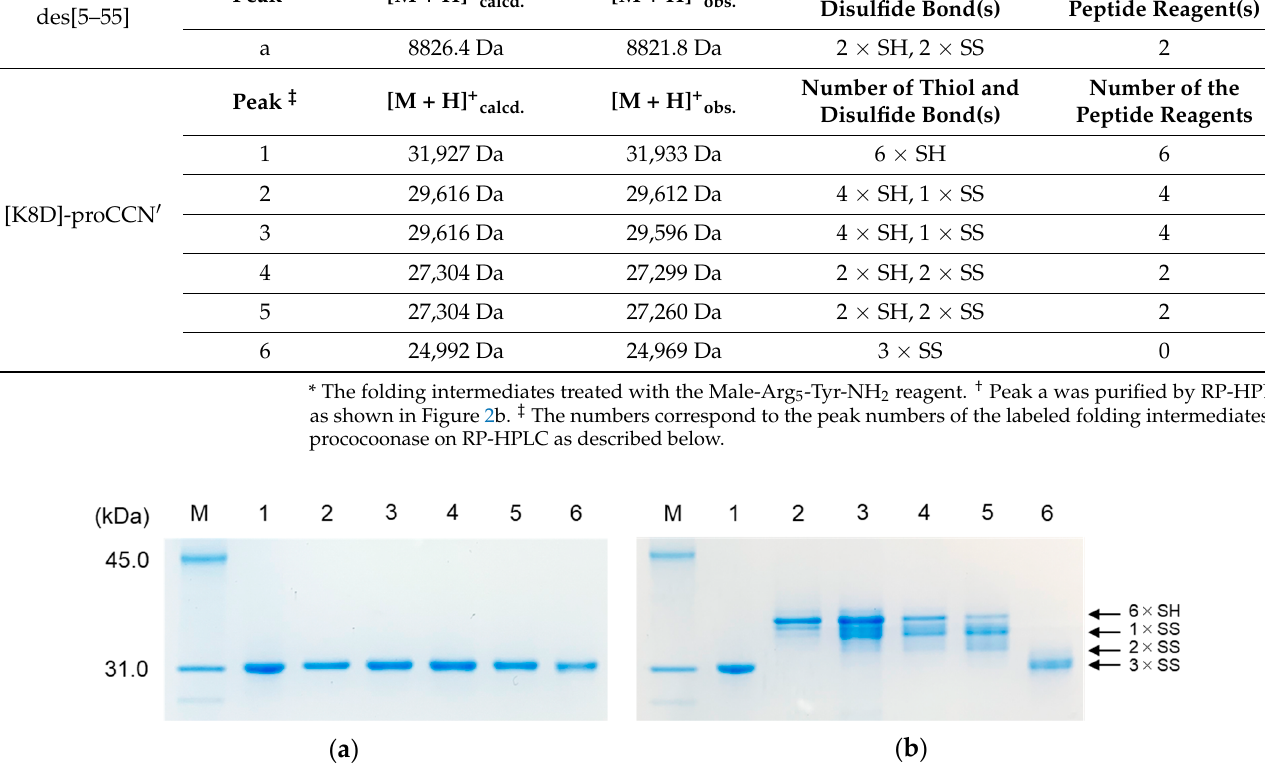
Figure 3. SDS-PAGE of the refolding mixtures of the [K8D]-proCCN’ protein. The refolding mixtures were treated with N -ethylmaleimide ( a ) or the Male-Arg 5 -Tyr-NH 2 reagent ( b ) at each time point. The reaction mixtures (without treatments) were applied to lane 1. Lanes 2, 3, 4, 5, and 6 were the refolding solutions at the reaction times of 0, 1, 2, 3, and 24 h, respectively. The folding intermediates are indicated by